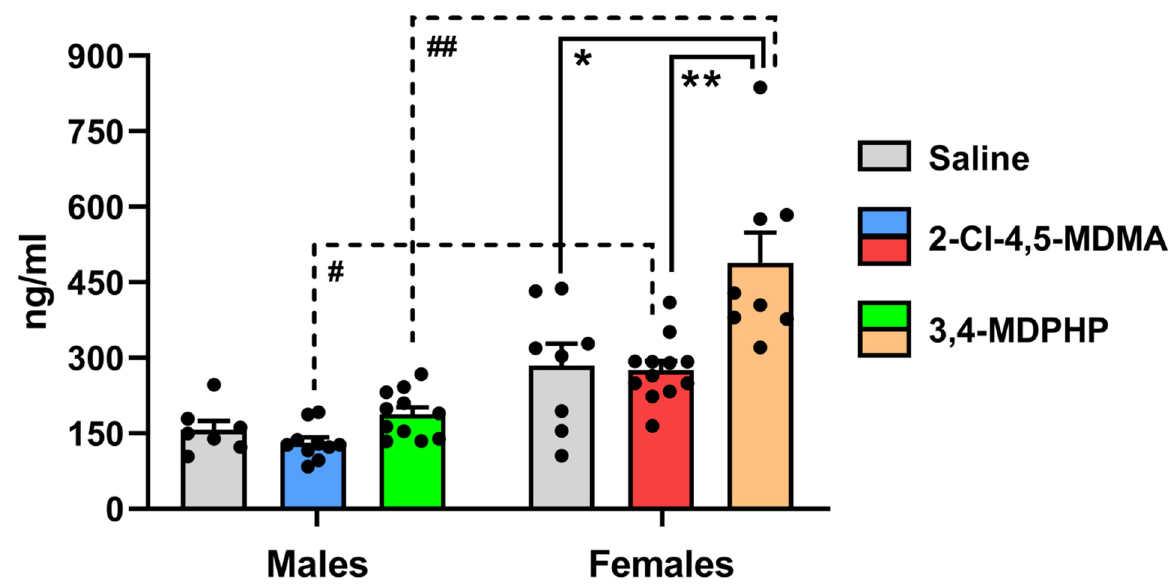
Figure 3. Effect of 2-Cl-4,5-MDMA and 3,4-MDPHP administration on plasma corticosterone levels in male and female rats . Corticosterone levels measured in plasma (expressed as nanograms per milliliter of plasma) of male and female rats at the end of the self-administration training. Data are expressed as mean ± SEM of values from 7 to 12 rats per group (males: saline, n = 7; 2-Cl-4,5-MDMA, n = 10; 3,4-MDPHP, n = 11; females: saline, n = 8; 2-Cl-4,5-MDMA, n = 12; 3,4-MDPHP, n = 8). * p < 0.001 and ** p < 0.0001 vs. the respective 3,4-MDPHP-treated group; # p < 0.01 and ## p < 0.0001 vs. the respective female group; two-way ANOVA followed by Tukey’s multiple comparisons